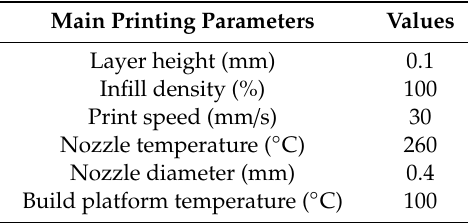
Table 2. Settings of 3D printer.